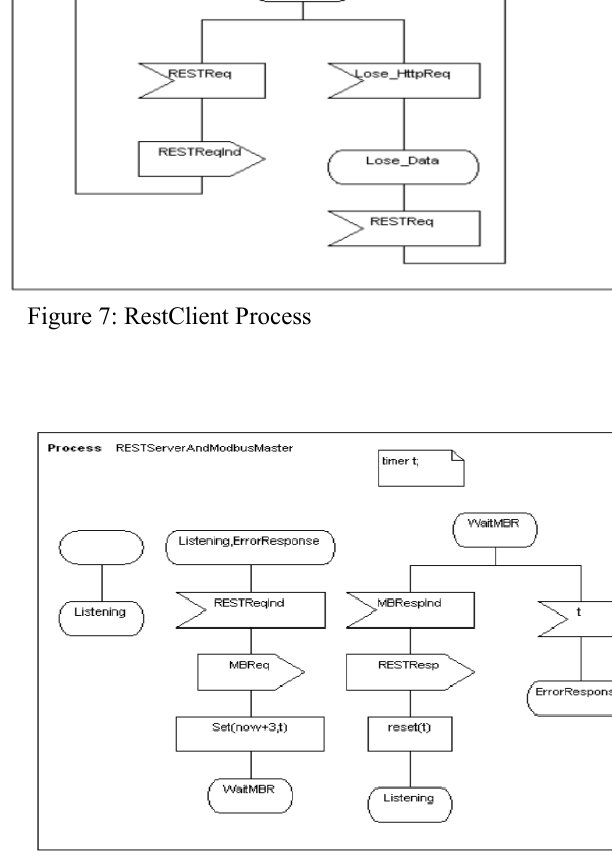
Figure 8: RESTServerAndModbusMaster